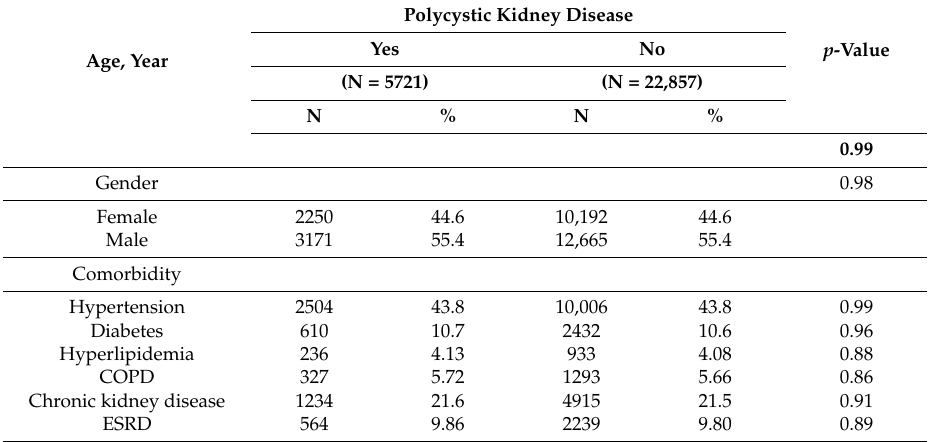
Table 1. Characteristics of patients between patients with and without polycystic kidney disease (PKD).